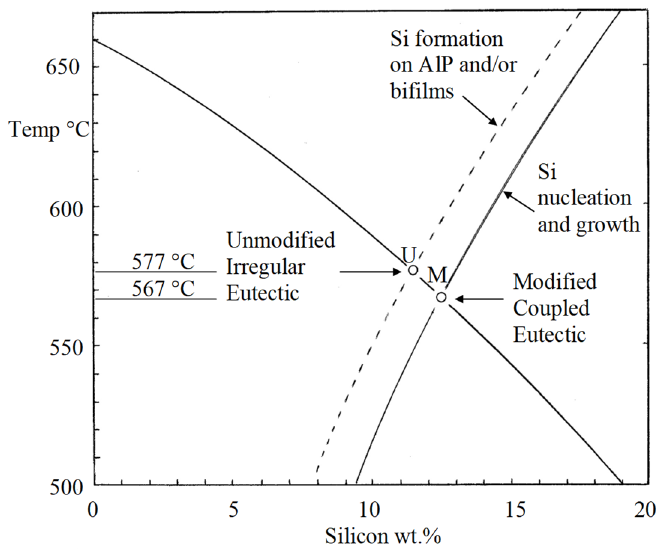
Figure 8. Al–Si phase diagram illustrating the two separate